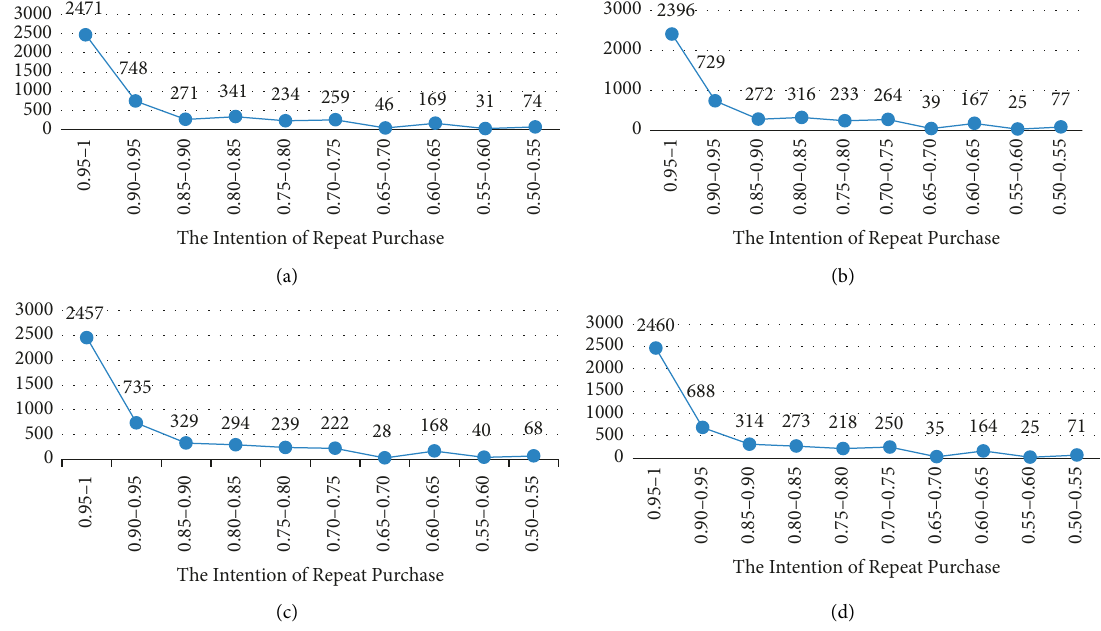
Figure 5: Numbers of air travelers purchased. (a) Numbers of customers purchased (A-A). (b) Numbers of customers purchased (A-B). (c) Numbers of customers purchased (B-A). (d) Numbers of customers purchased